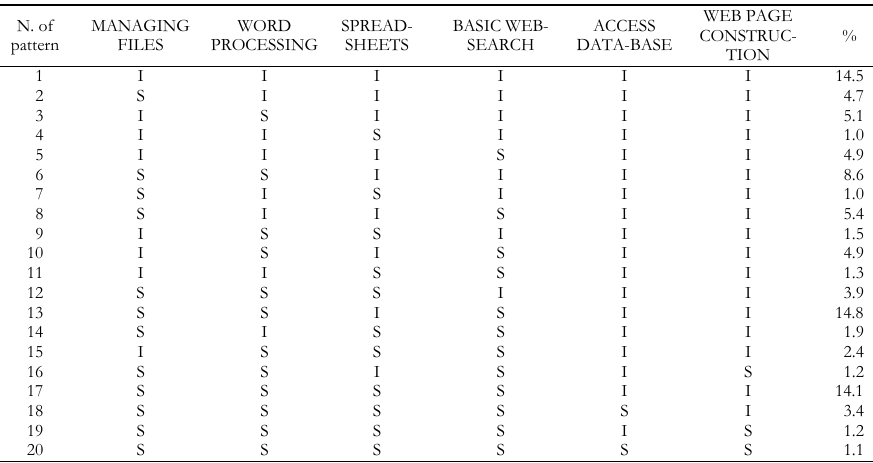
Different patterns of performances WORD SPREAD- PROCESSING